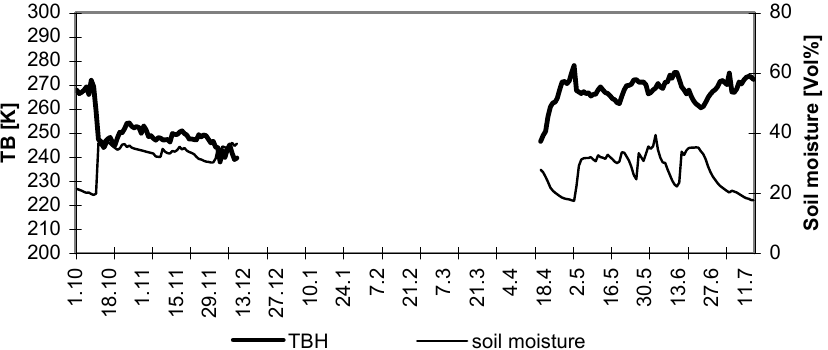
Figure 8. Development of TB and soil moisture in 5 cm depth – 50°, horizontal